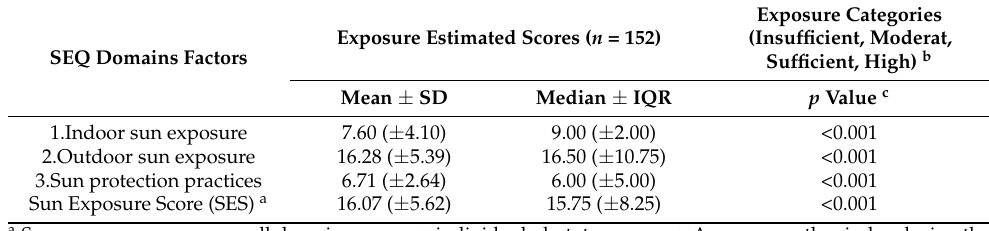
Table 3. Sun exposure score and sunlight categories assessed by the SEQ in 152